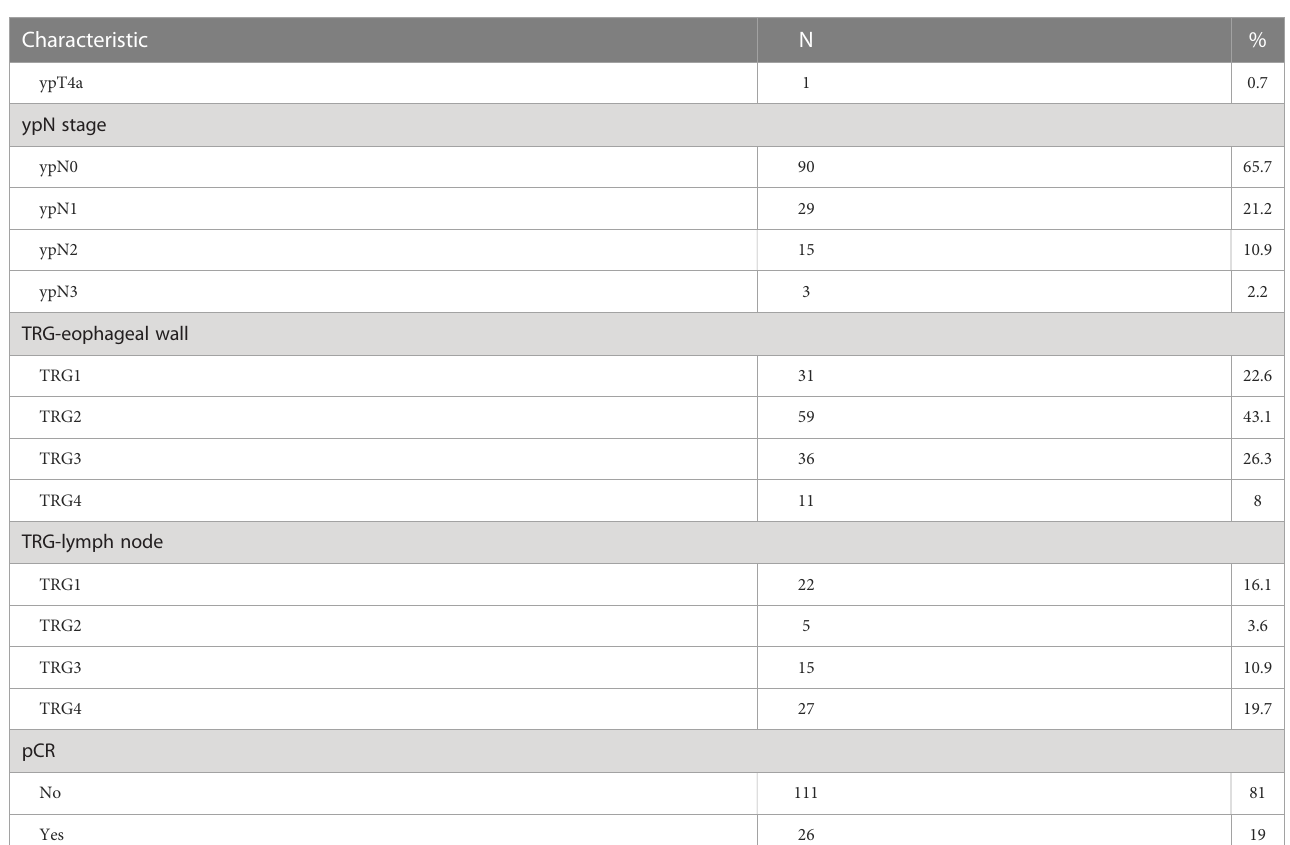
38.2% (21/55) in the muscularis propria, and 89.1% (6/25) in the lymph nodes. Figure 3A provides the relative distribution of residual tumor within the esophageal wall and lymph nodes in 55 patients. The mucosa had residual tumor cells signi fi cantly more frequently than the submucosa and muscularis propria ( P <0.001).